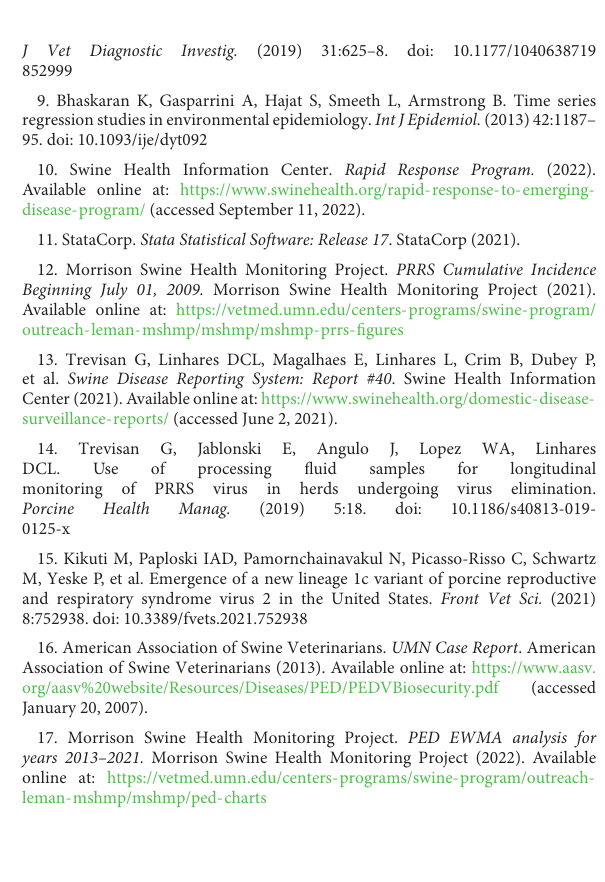
SUPPLEMENTARYFIGURE1 Weekly prevalence of status 1 farms and weekly percentage of processing fluids submissions over time. SUPPLEMENTARYFIGURE2 Deviance residual of the Poisson model with adjustment for long-term patterns with spline function. SUPPLEMENTARYTABLE1 Lowest, median and highest weekly PRRS prevalence by year. ∗ 2009 weekly prevalence comprise data from July to December only. SUPPLEMENTARYTABLE2 Contrasts of global mean of time to stability by each level of categorical